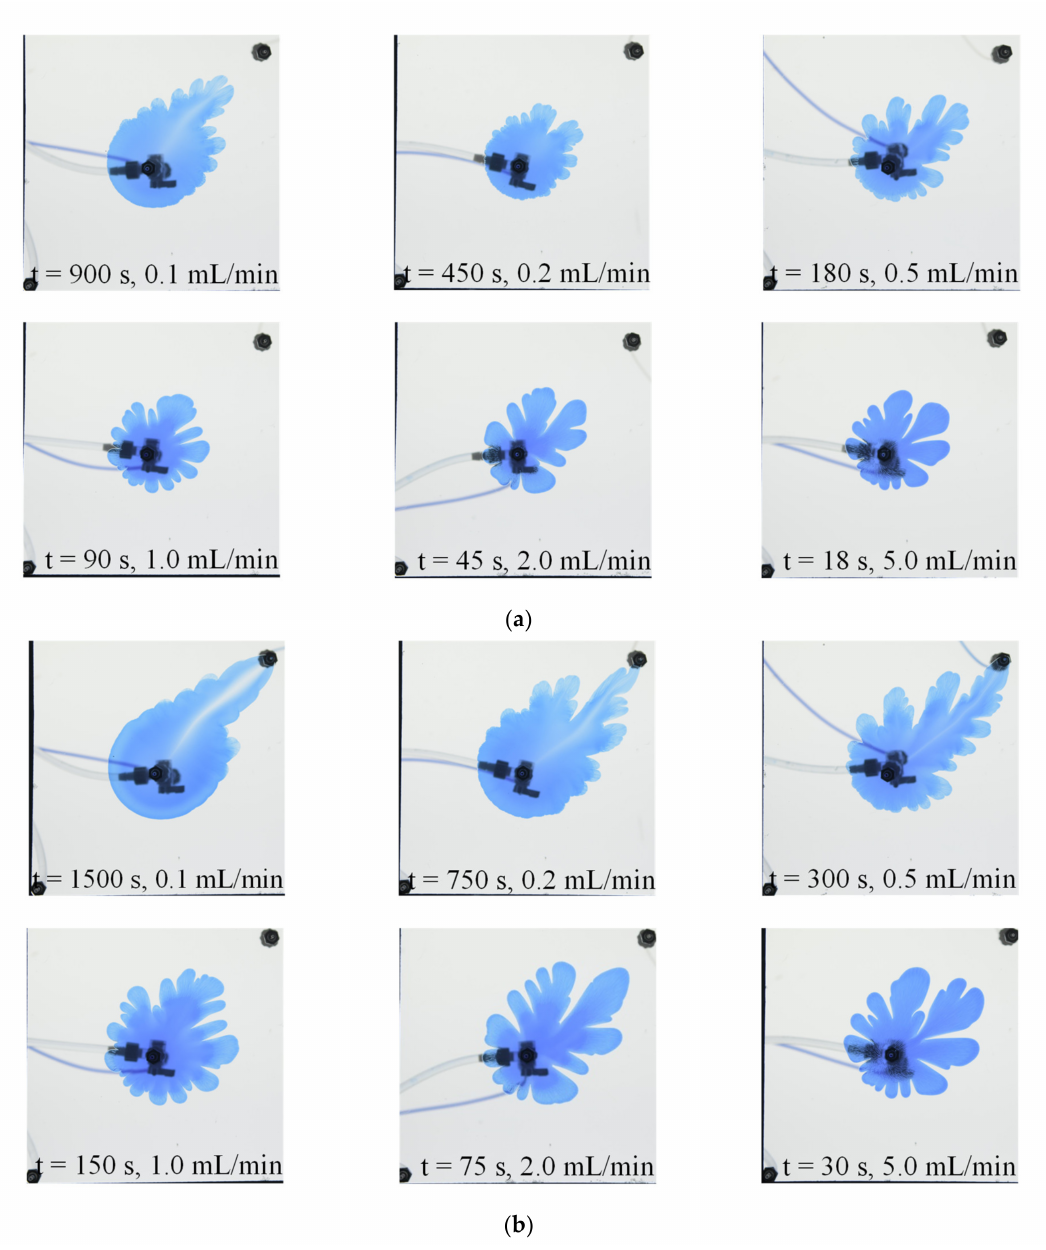
Figure 13. Water plumes at fixed volume of water injected for the control of constant production rate at outlet: ( a ) at 1.5 mL water injected; ( b ) at 2.5 mL water